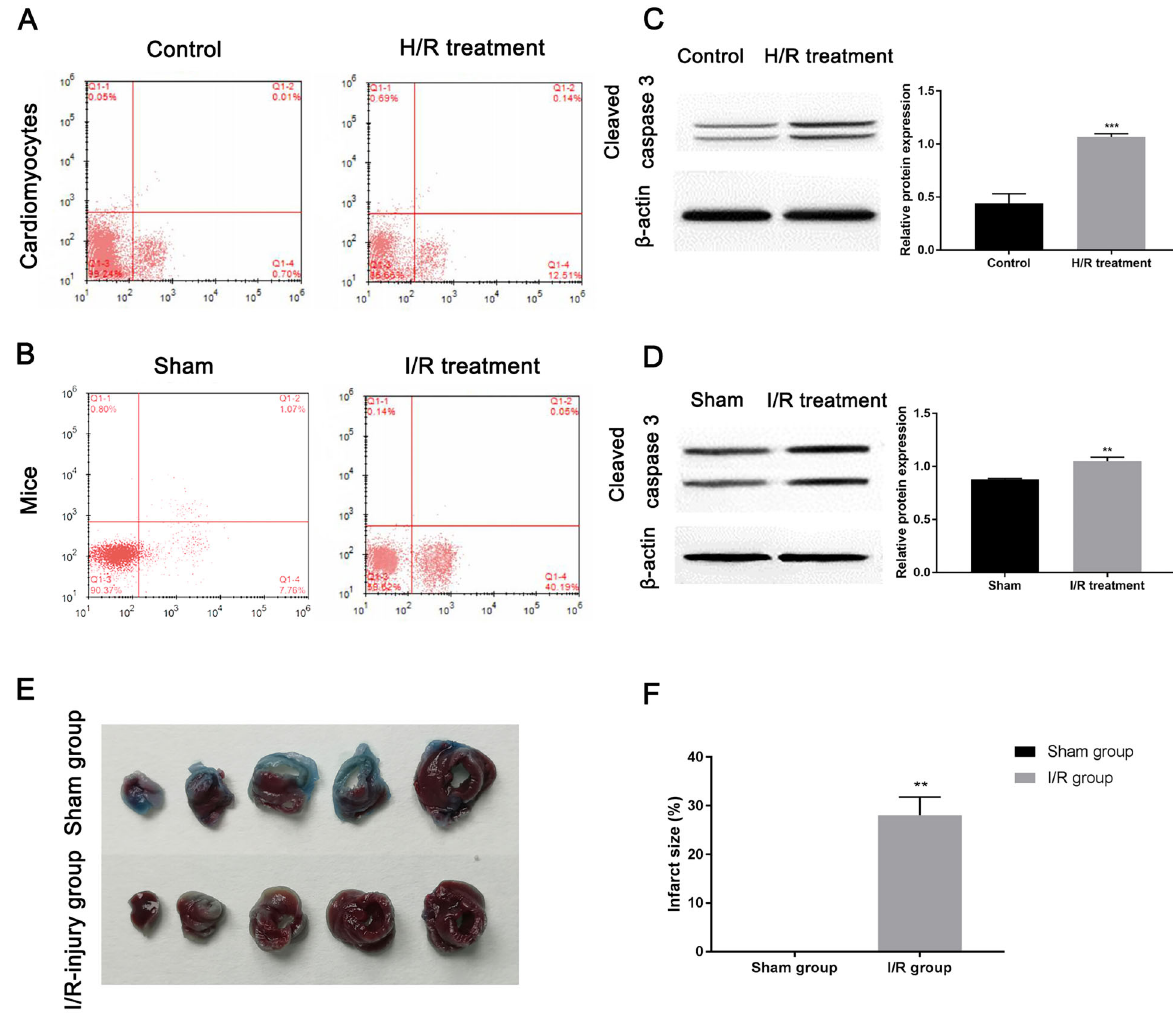
Figure 1. Establishment of ischemia/reperfusion (I/R) injury model. The images of fl ow cytometry show apoptosis in ( A ) cardiomyocytes and ( B ) myocardium of mice upon I/R injury. Western blot examined the expression of cleaved caspase 3 in ( C ) cardiomyocytes submitted to hypoxia/reoxygenation (H/R) treatment and ( D ) myocardial tissue upon I/R treatment. E , Representative images of Evans blue/TTC staining in fi ve continuous slices of left ventricle from mice hearts treated with or without I/R treatment. F , The infarct size was quanti fi ed by Image-Pro Plus software. Data are reported as means ± SD. **P o 0.01, ***P o 0.001 vs control groups ( t -test).